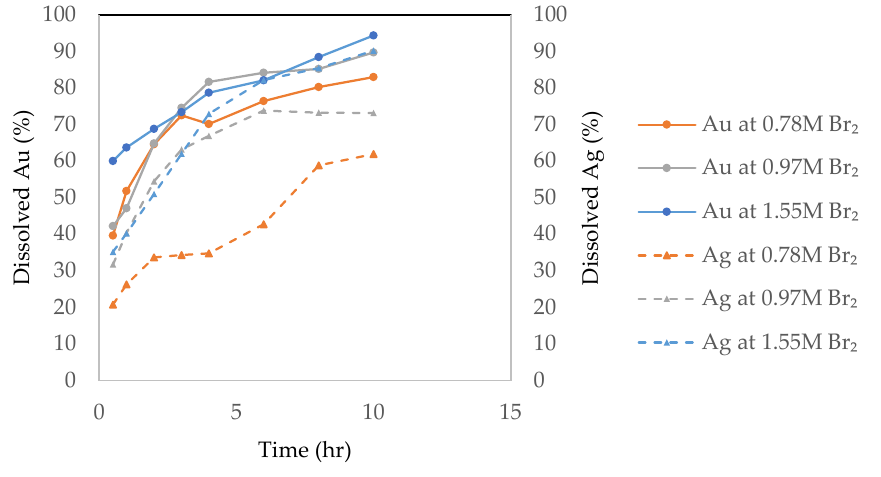
Figure 7. Dissolution of gold and silver at various concentrations of liquid bromine (23.5 °C and natural pH).